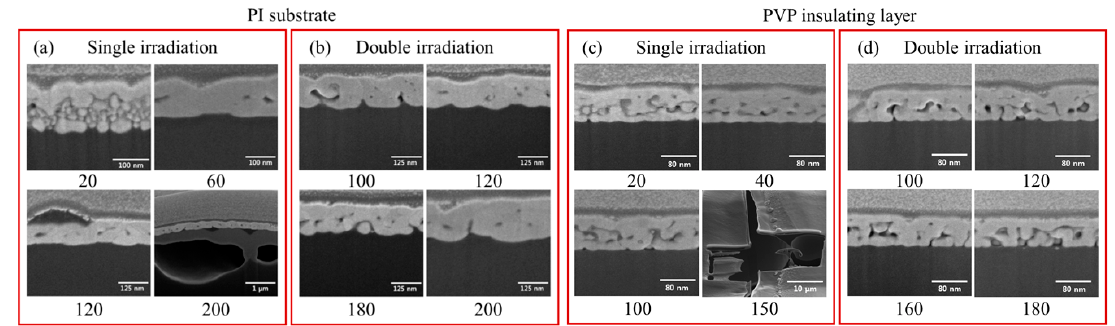
Figure 2. Cross-sectional SEM images of Ag electrode sintered by ( a , c ) single and ( b , d ) double laser irradiation with different power on PI substrate and PVP insulating layer. The numbers underneath each SEM image indicate the laser power.